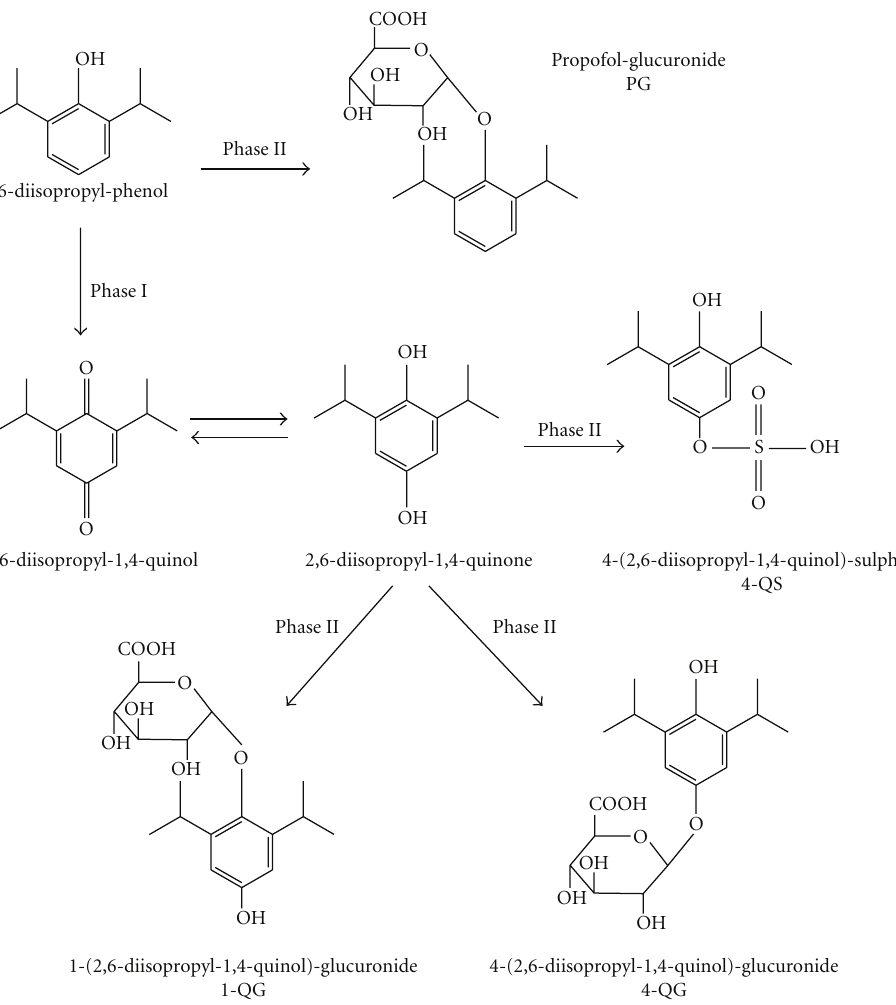
Figure 2: The main metabolic pathway of propofol. In phase I, the metabolism of propofol to 2,6-diisopropyl-1,4-quinol by cytochrome P450 is the rate-limiting step in the formation of 1-QS, 4-QG, and 4-QS. In phase II, the major metabolite was a glucuronic acid conjugate of propofol (propofol-glucuronide) and the minor metabolites were quinol derivatives (1-QG, 4-QG, and 4-QS)